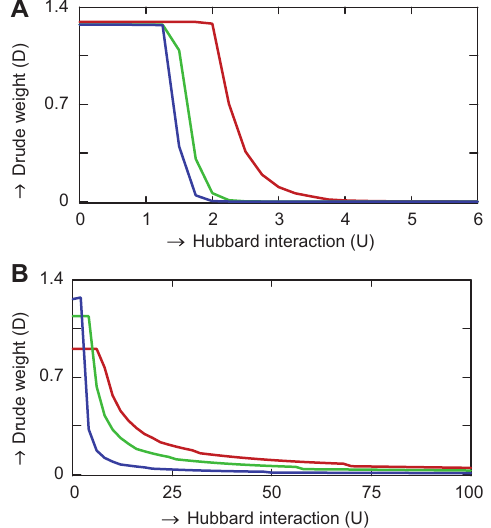
Figure 4 Persistent current as a function of fl ux φ for single- channel mesoscopic rings in half-fi lled case. (A) N = 15. The red, green, and blue curves correspond to U = 0, 1.5, and 2, respectively. (B) N = 20. The red, green, and blue curves correspond to U = 0, 1, and 1.5, respectively.